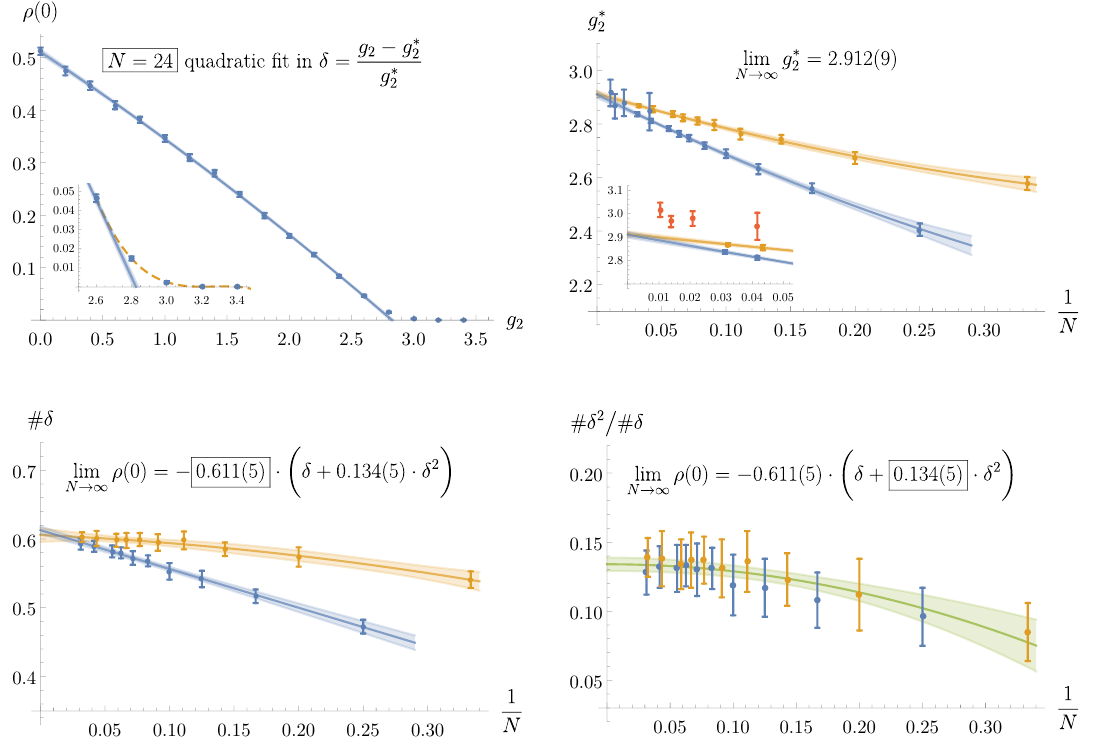
in the large- N limit for ( g ) = 4 , g r 2